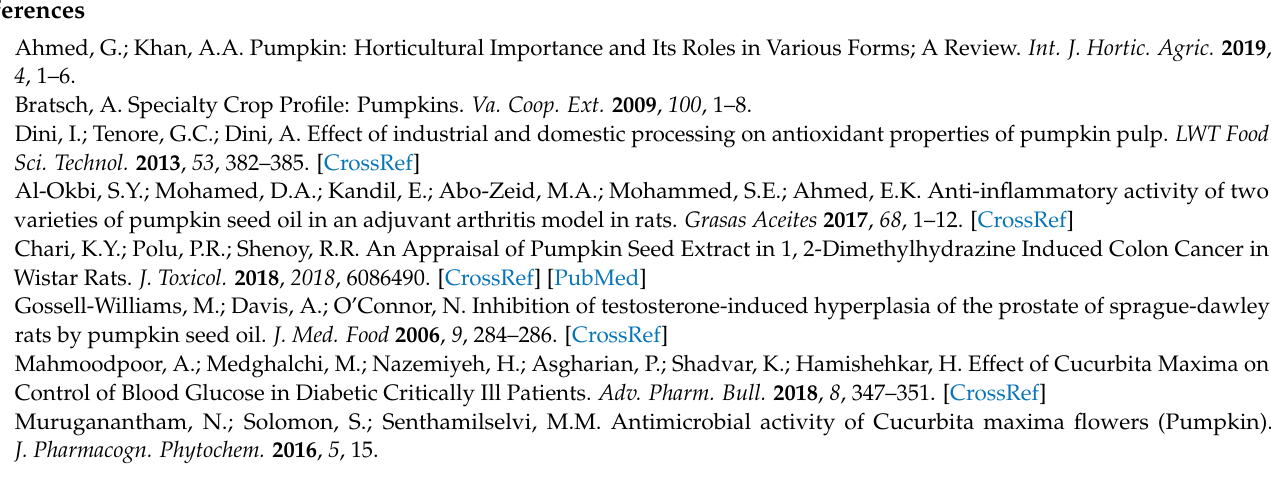
diameter; Figure S1: Images of Serbian pumpkins with scale bars; Figure S2: Images of non-Serbian pumpkins with scale